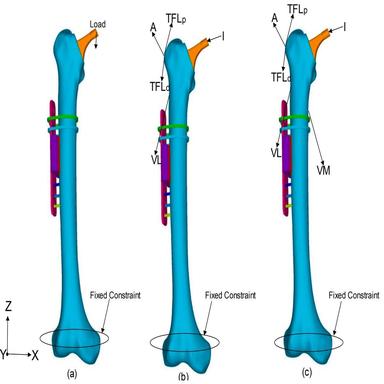
Loading and boundary conditions at the FE model for (a) standing posture, (b) walking, and (c) stair climbing. (I: intersegmental joint muscle forces; A: abductor; TFLp: tensor fascia latae proximal; TFLd: tensor fascia latae distal; VL: vastus laterallis; VM: vastus medialis)